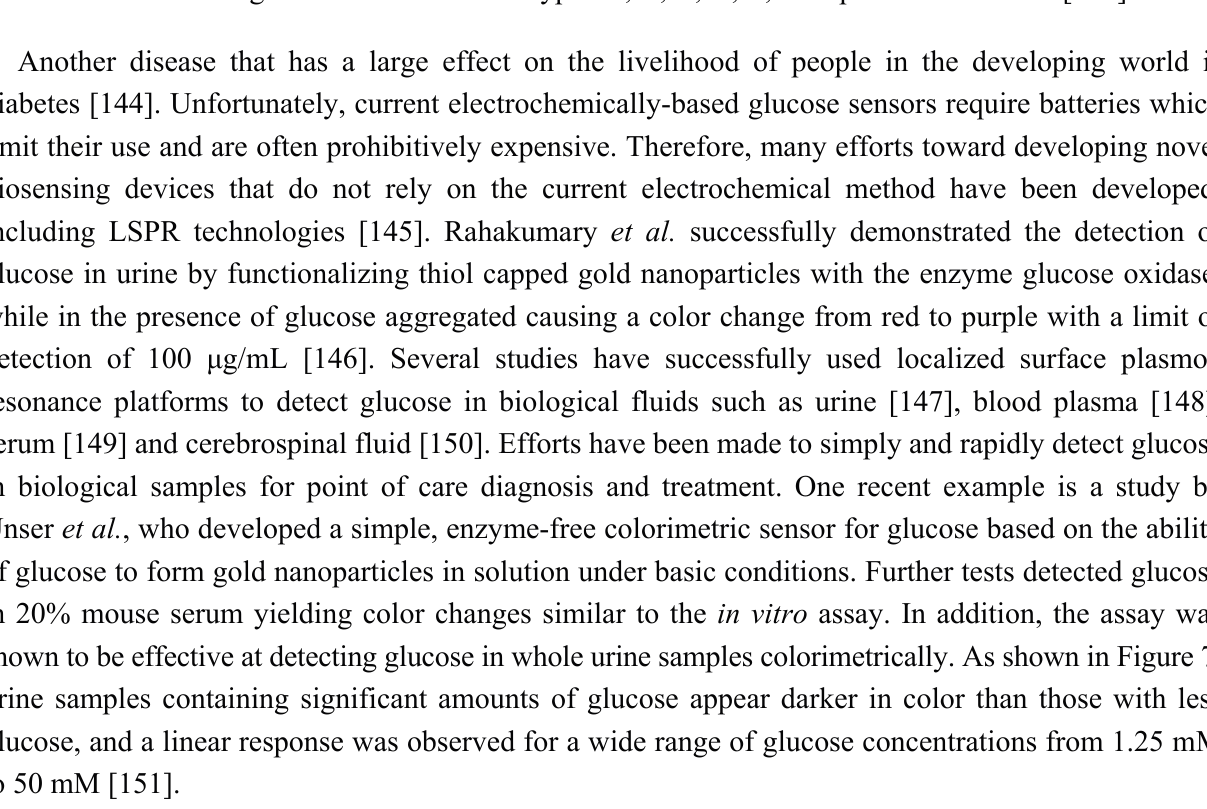
urine samples containing significant amounts of glucose appear darker in color than those with less glucose, and a linear response was observed for a wide range of glucose concentrations from 1.25 mM to 50 mM